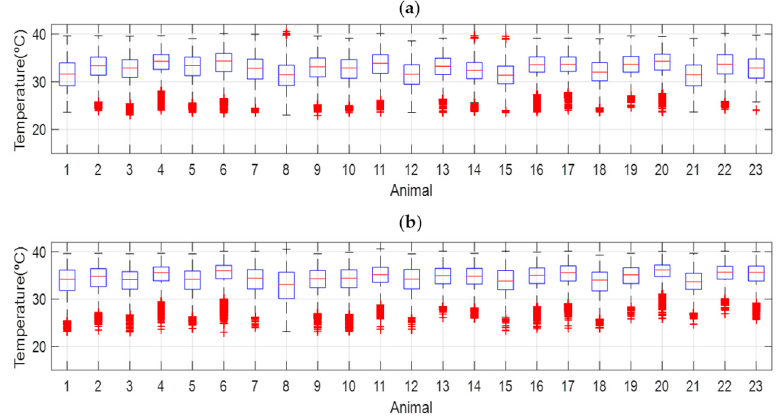
Figure 6. Boxplot of the ( a ) day and ( b ) night temperature for each monitored animal. Central mark indicates the median, and the bottom and the top of the edges of the boxes indicate the 25th and 75th percentiles respectively. The whiskers extend to the most extreme data points not considered outliers, and the outliers are plotted individually using the '+' symbol.